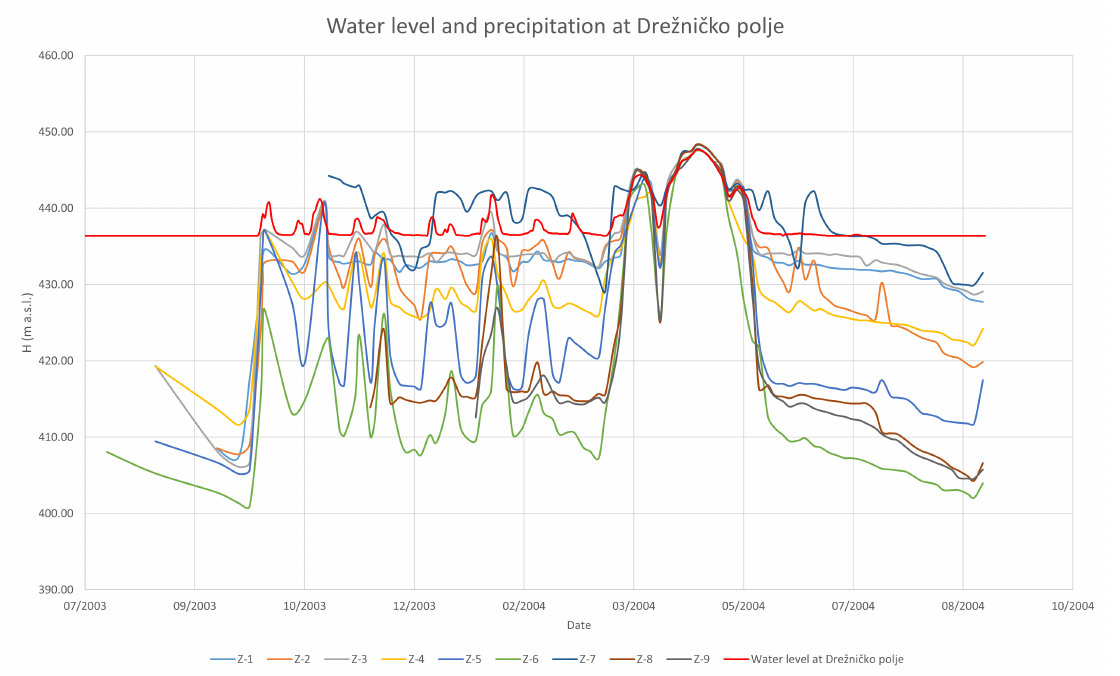
Figure 6. The level curves of all piezometers show very similar frequencies and trends, regardless of the difference in the water